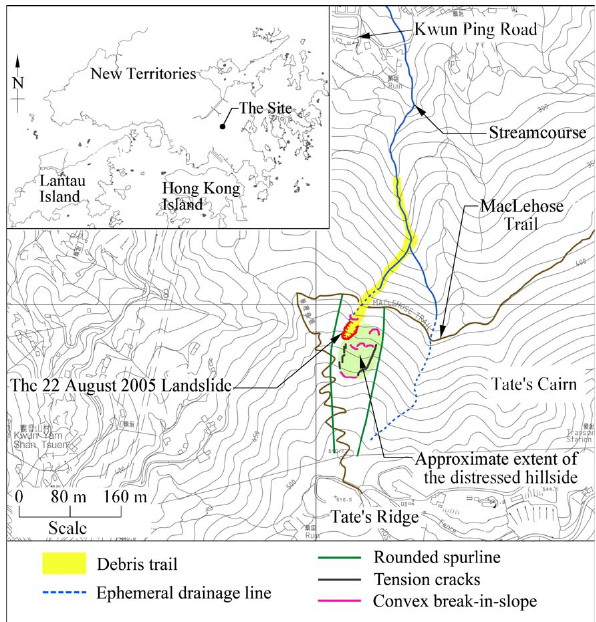
Fig. 1. Location and layout plans of the study area (modified after MGS, 2007).